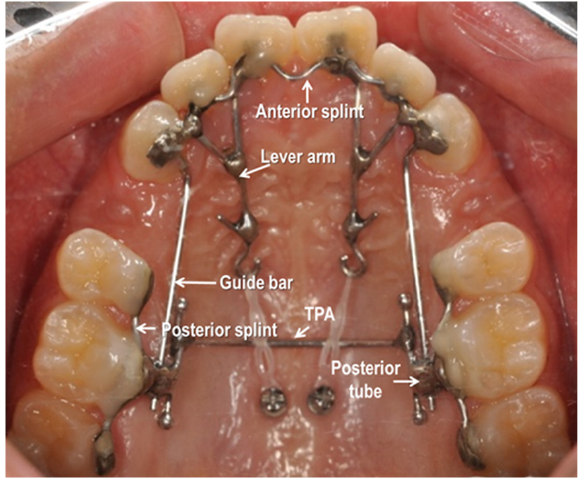
Figure 7. Antero-posterior Lingual Retractor (APLR) appliance.